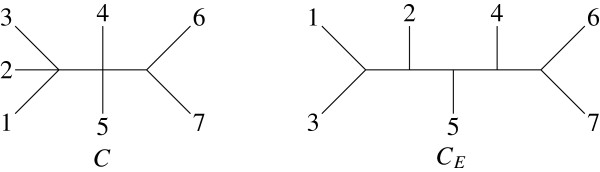
The majority consensus tree C and an extended one CE.